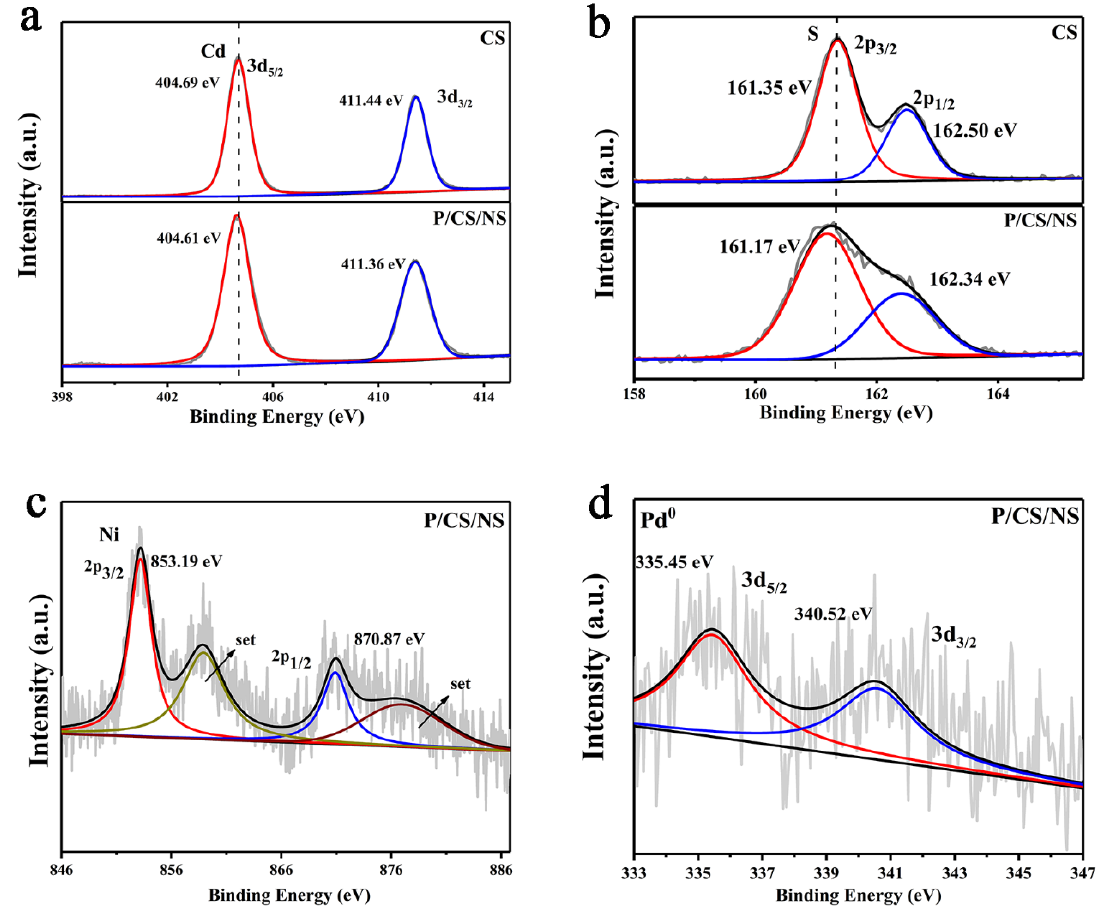
Figure 4. High-resolution XPS spectra of ( a ) Cd 3d; ( b ) S 2p in CdS and Pd/CdS/NiS, ( c ) Ni 2p; ( d ) Pd 3d in Pd/CdS/NiS.